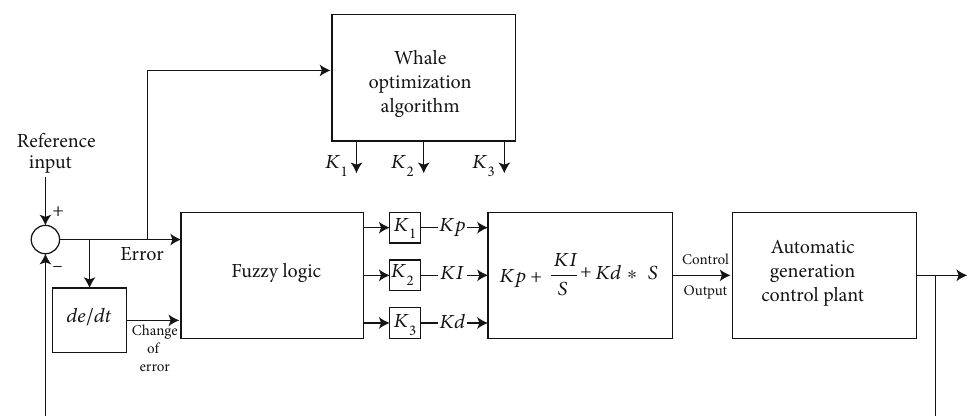
Figure 4: Fuzzy PID controller tuning by whale optimization